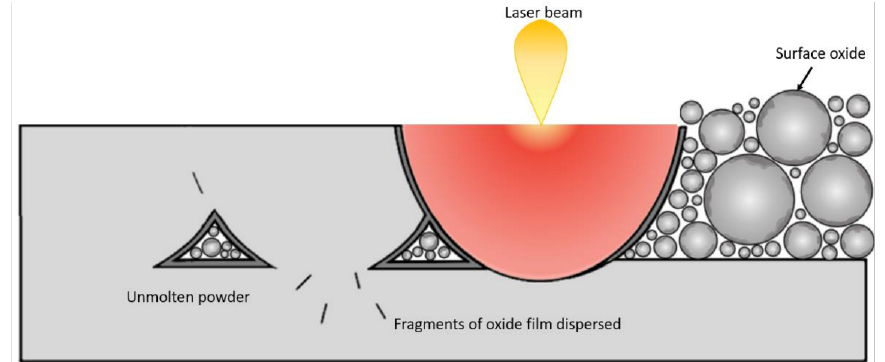
Figure 4. The mechanism of oxide film formation, its disruption and resulting